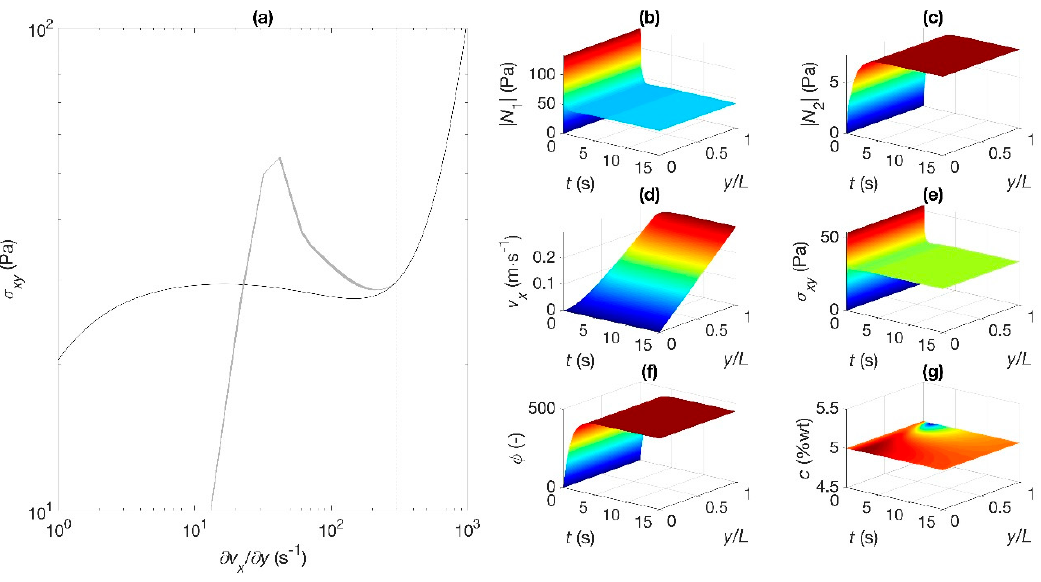
Figure 6. Dynamics and steady state under controlled shear rate. Reference shear rate is 300 s − 1 . Temporal trajectory of the stress and shear rate for various spatial positions ( a ), evolution of the normal stress differences N 1 ( b ) and N 2 ( c ), velocity ( d ), shear stress ( e ), fluidity ( f ), and concentration ( g ), in space and time.